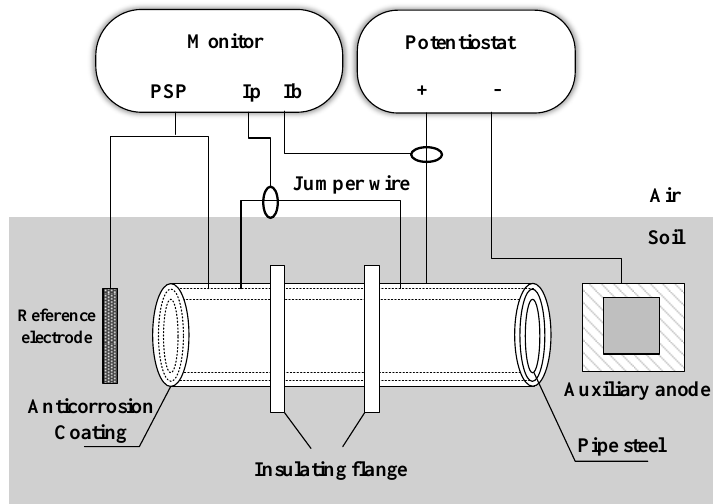
Figure 2. Structure of the cathodic protection station and installation of the monitor, the PSP of the pipeline is the potential difference between pipeline and reference electrode, I p is the current in jumper wire, I b is the current output by potentiostat.